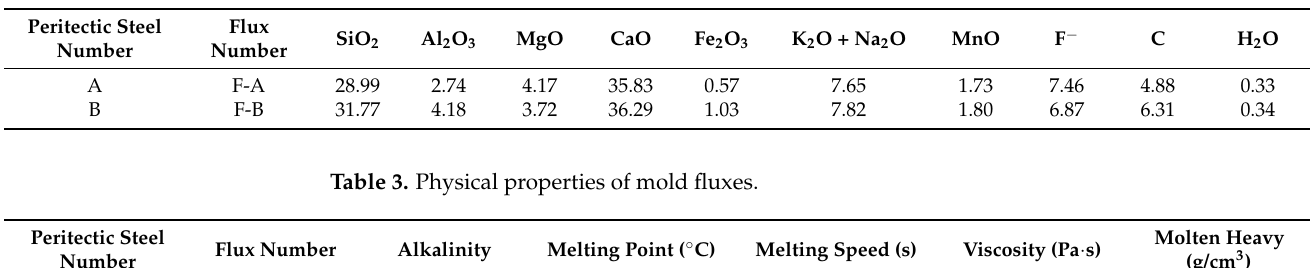
Table 2. Chemical compositions of mold fluxes (wt%).